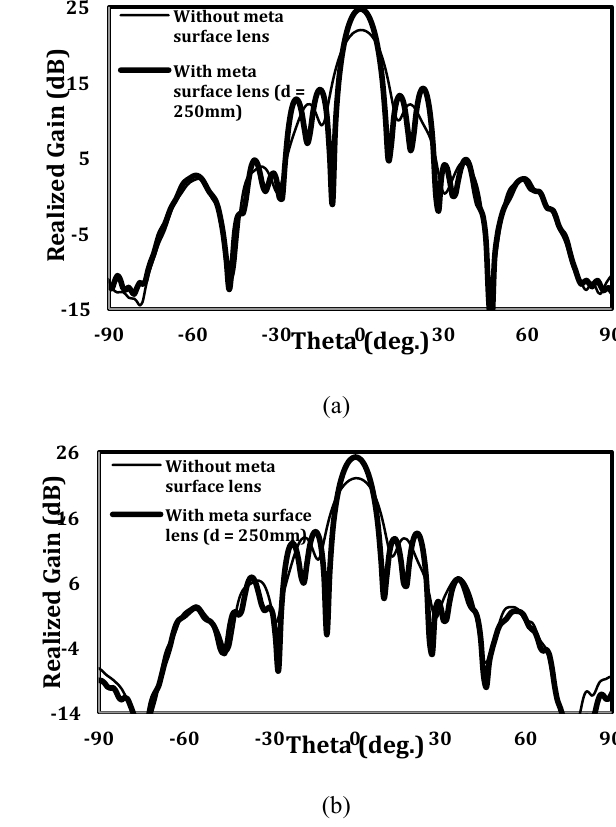
Figure 4: Simulated realized gain with respect to number of column and row meta surface lens at 10GHz respectively. (a) Gain versus number of columns of strip, (b) gain versus number of rows of strip, (c) gain versus number of columns of strip with fixed row and (d) gain versus number of rows of strip with fixed column.